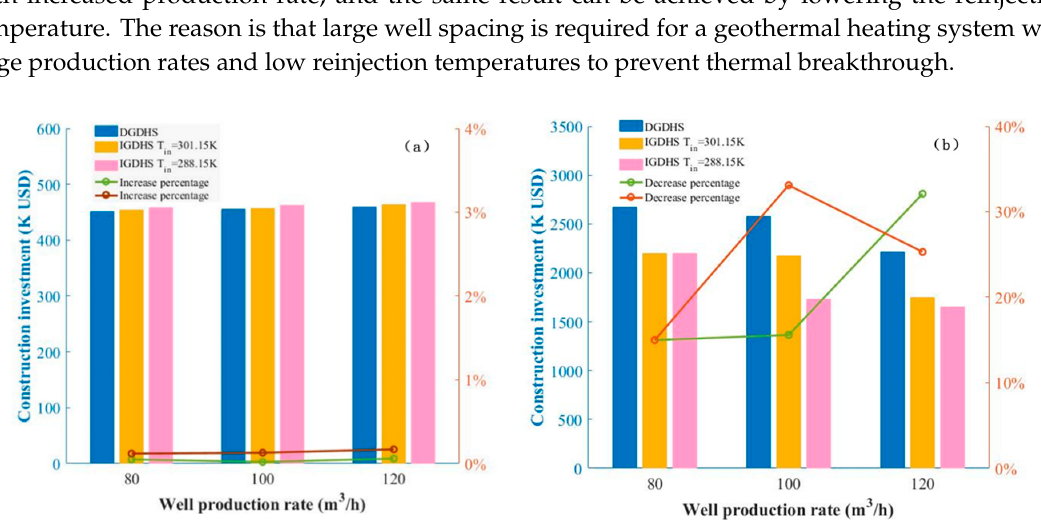
Figure 14. Annual power consumption of different geothermal heating systems: ( a ) electricity cost; ( b ) water cost. As shown in Figure 15, DGDHS has a longer payback period than IGDHS. Actually, annual power consumption of DGDHS is lower, because there are no heat pumps, but the high cost of construction investment and equipment depreciation causes a longer payback period. On the contrary, IGDHS consumes large amounts of electricity during operation, but the initial investment for a geothermal heating system is lower, which greatly reduces the payback period. As reinjection temperature is lower, the payback period becomes longer. That is because the annual power consumption of a geothermal heating system with low reinjection temperature is significantly higher than other systems. An indirect geothermal district heating system for building heating in the case of Xinji, China, is the best heating mode. The optimal production rate, reinjection temperature, and well spacing for a 50-year heating period are 100 m 3 /h, 301.15 K, and 300 m, respectively.